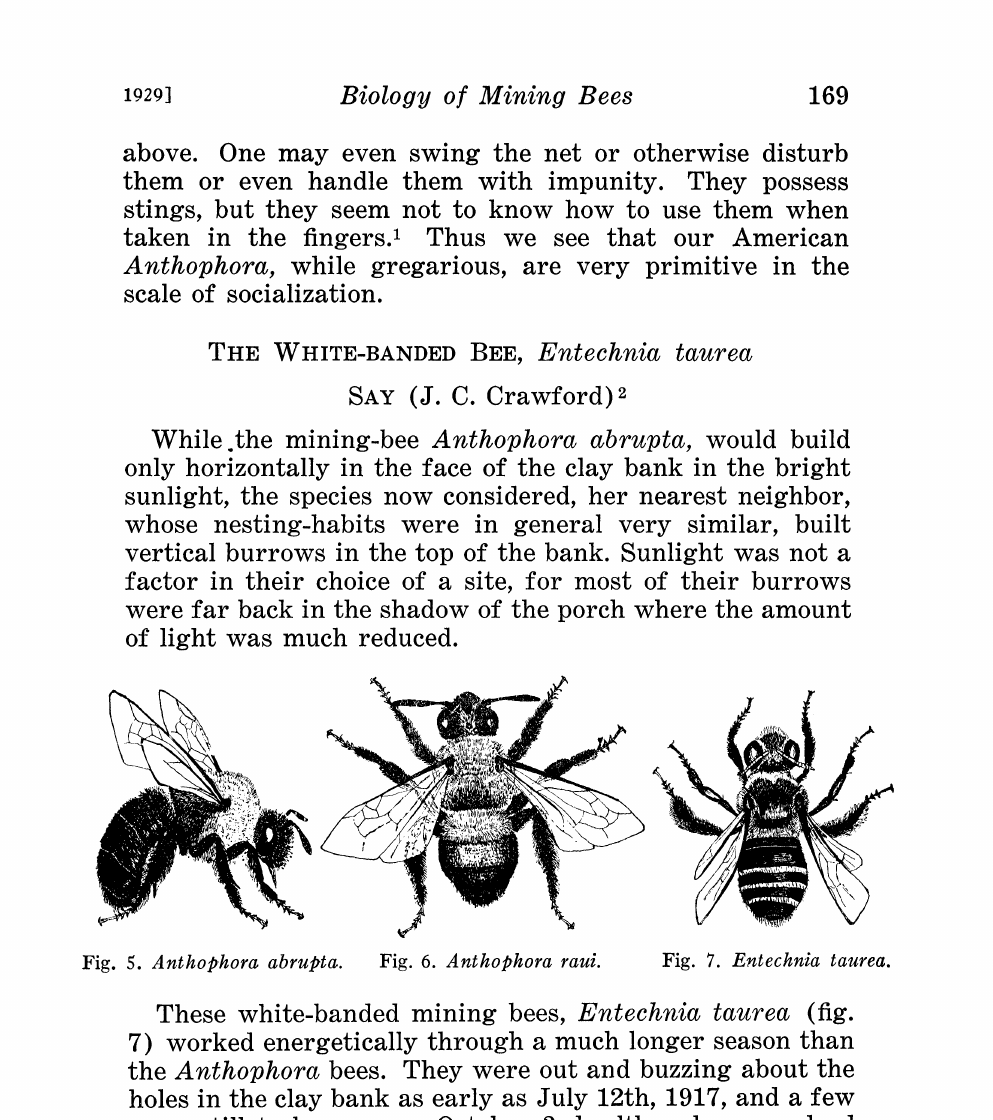
Fig. 5. Anthophora abrupta. Fig. 6. Anthophora raui. Fig. 7. Entechnia